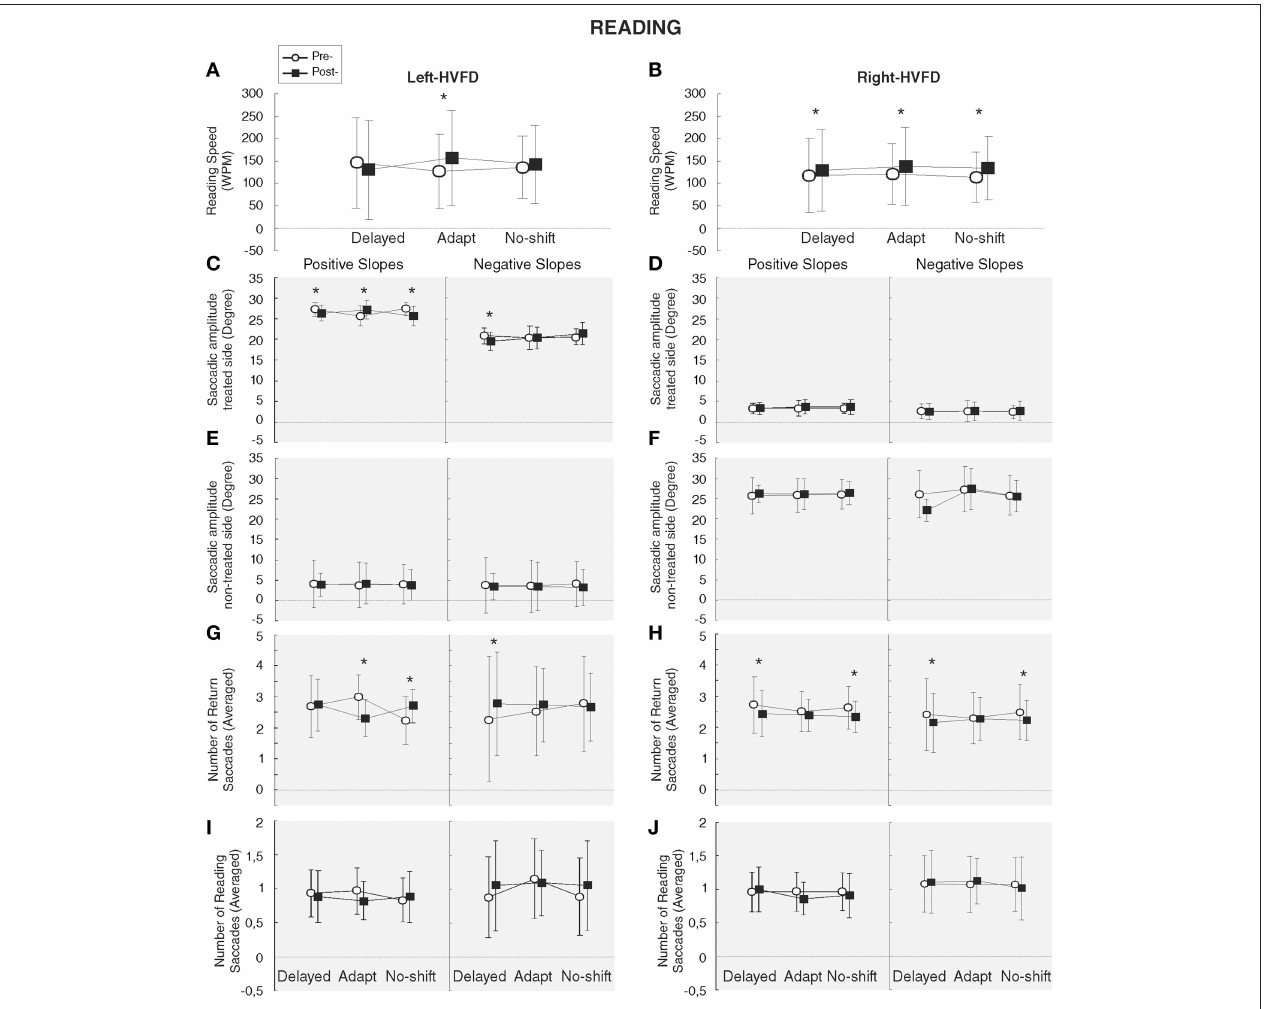
FIGURE 6 | Results of reading task. Functional and oculomotor (gray background) measures are represented separately for the left-HVFD (A, C, E, G, I) and right-HVFD (B, D, F, H, J) patients. Oculomotor measures include the amplitude of saccades toward the treated-side ( C,D ), non-treated side (E,F ) in degree and the number of return ( G,H ) and reading ( I,J ) saccades. Bars represent the confident interval at 0.95. Stars represent the significant difference between pre- and post-phases revealed by Post-hoc LSD Fisher